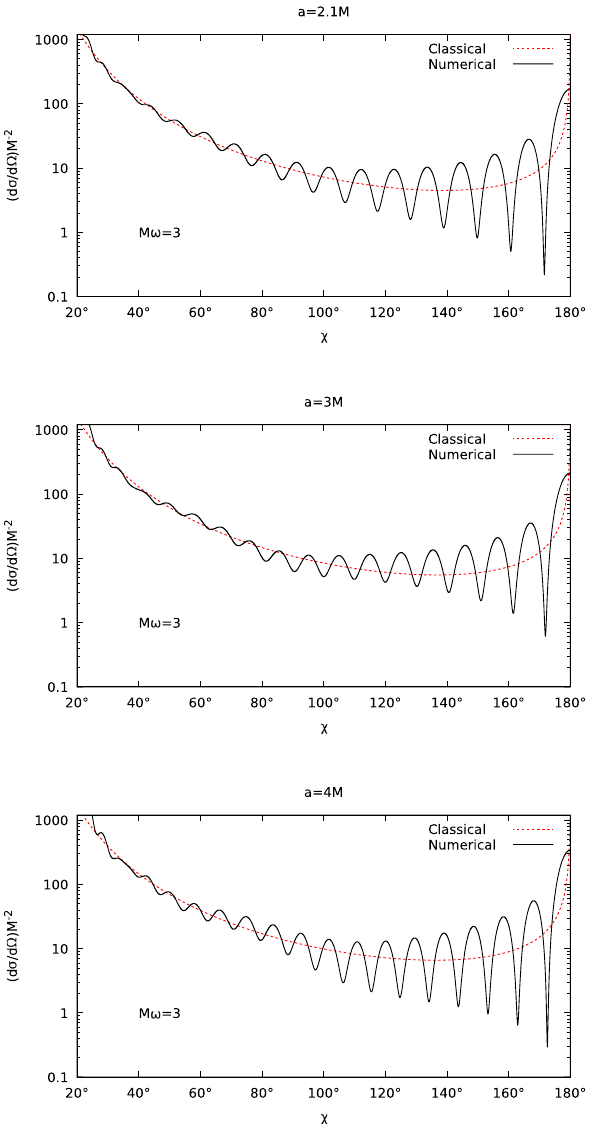
Fig. 6 Comparisonbetweenthescalardifferentialscatteringcrosssec- tion of traversable wormholes obtained with the full numerical analysis and the classical result, for M ω = 3 and different values of a / M